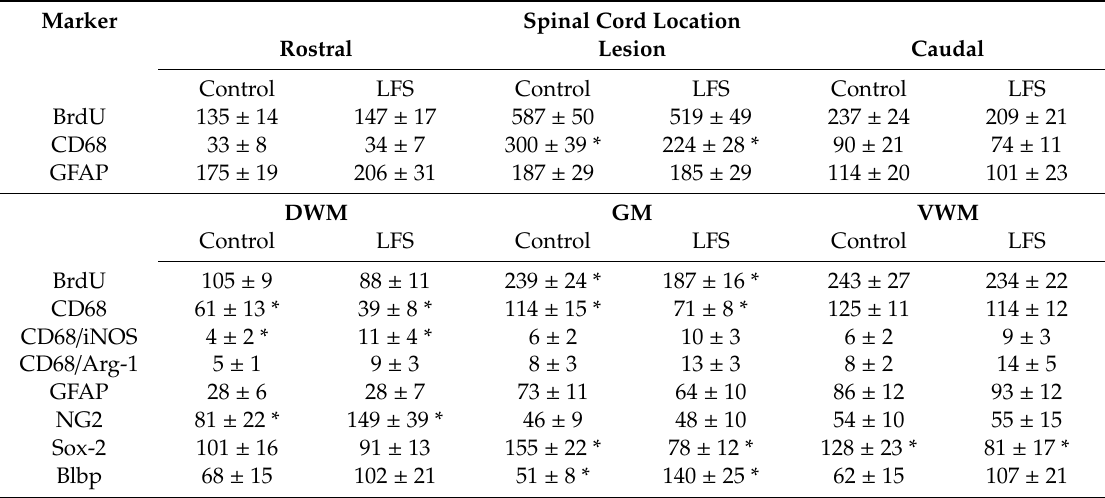
Table 1. E ff ects of LFS of NRM on cell counts for the di ff erent spinal cord locations examined. Marker Spinal Cord Location Rostral Lesion Caudal Control LFS Control LFS Control